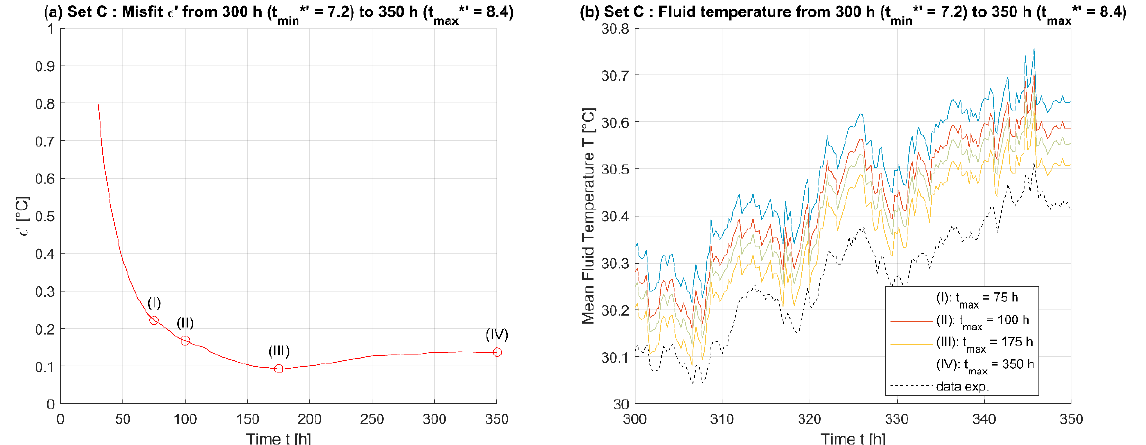
Figure 11. Set C: back-calculation of R b and x with a fixed value of λ m . ( a ) Evolution of the misfit ε ’ with the duration of integration t max . ( b ) Evolution of the temperatures from t min ’ to t max ’ for several values of t max .